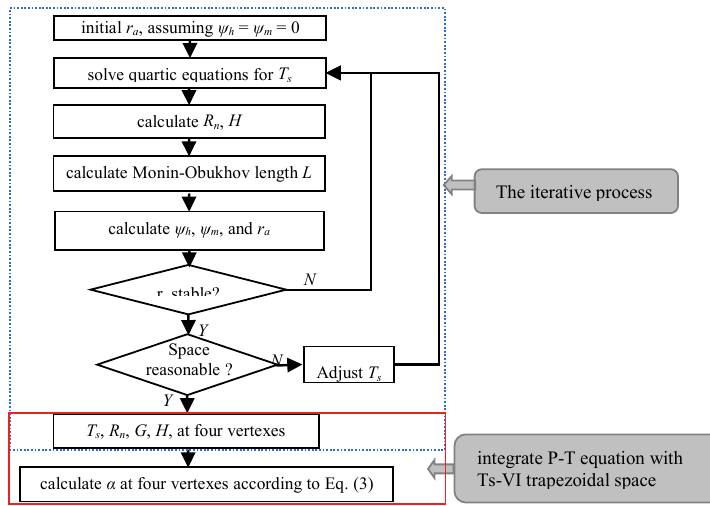
Fig. 2 Procedure for estimating sensible heat flux H with